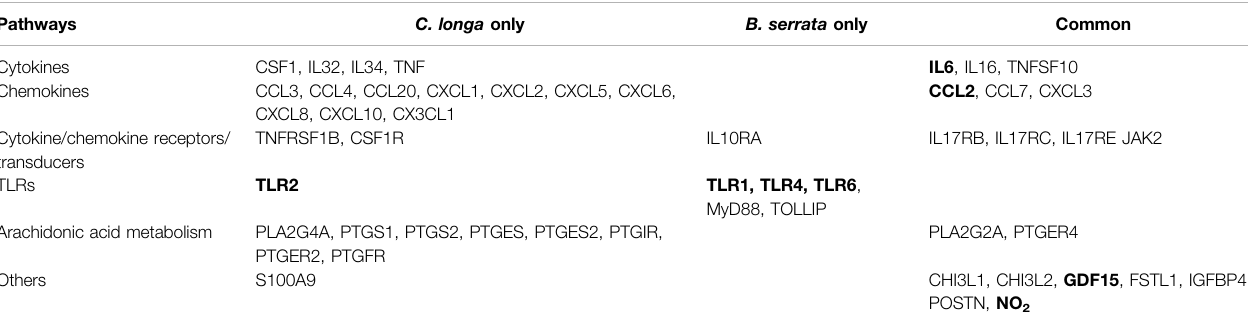
TABLE 1 | Summary of the anti-in fl ammatory main mechanisms of action of C. longa (2 μ g/ml) and B. serrata (50 μ g/ml) extract at 24 h. Pathways C. longa only B. serrata only Common